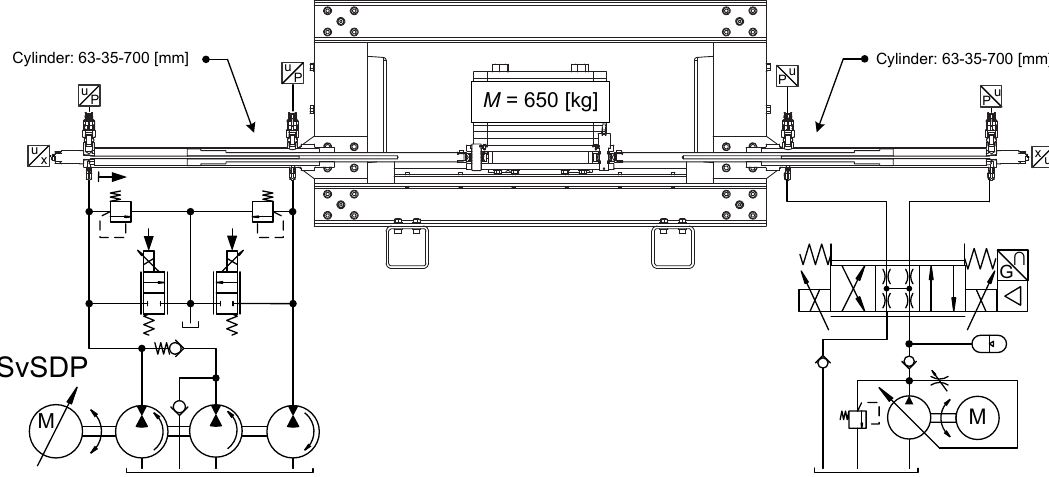
Figure A1. Test bench with the so-called Speed-variable Switched Differential Pump (SvSDP) prototype drive (Aalborg University, Denmark) [27].